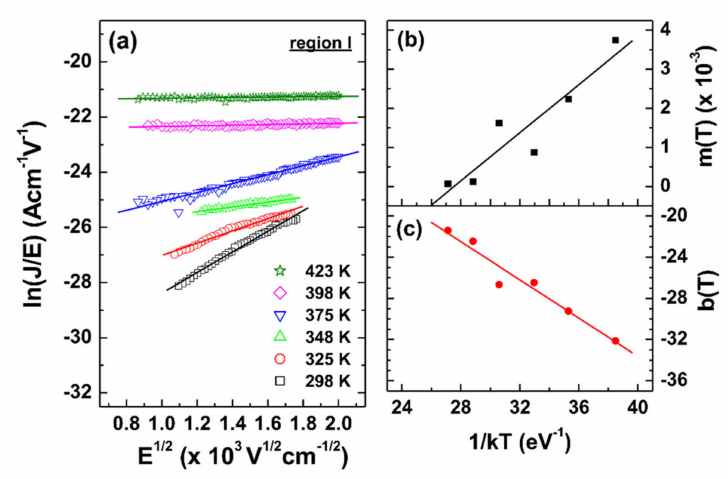
Figure 4. ( a ) Ln( J / E ) vs. E 1 / 2 / plots by the Poole–Frenkel (PF) emission model, together with the linear fitting to the experimental data for sample A. ( b , c ) The calculated m and b values, respectively.